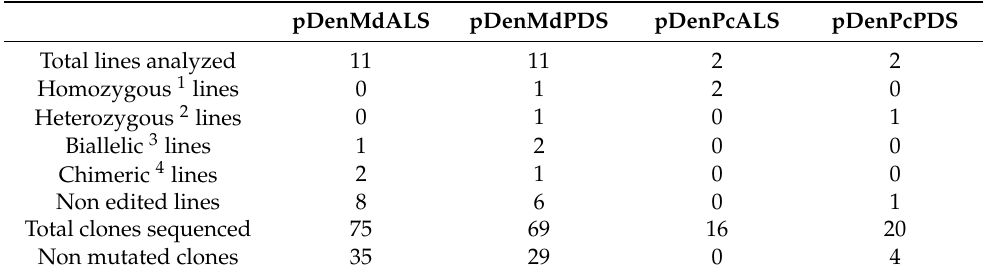
Table 3. Summary of editing profiles of transgenic lines